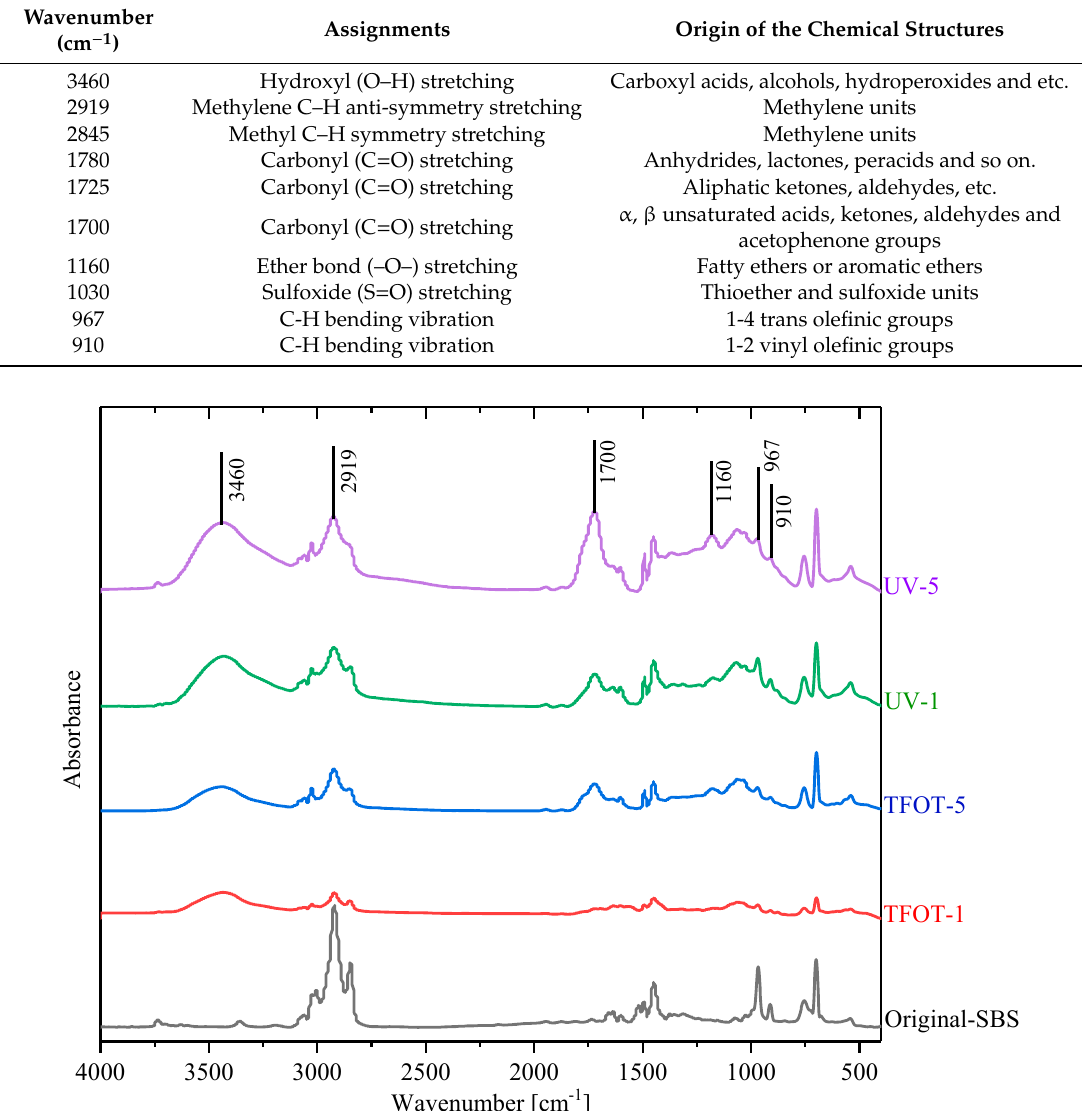
Table 6. Peaks and assignments.